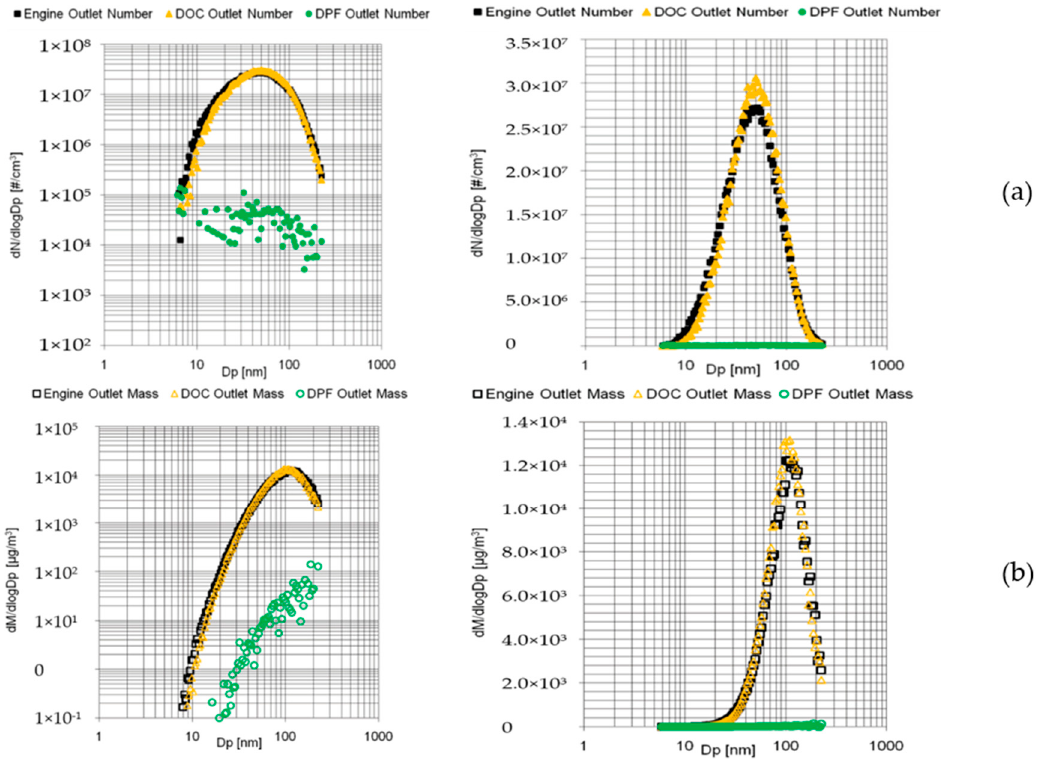
Figure 2. Mass-size distribution of PM ( a ) and the number of particles ( b ) under normal engine operation (1750 RPM/3.5 bar BMEP)